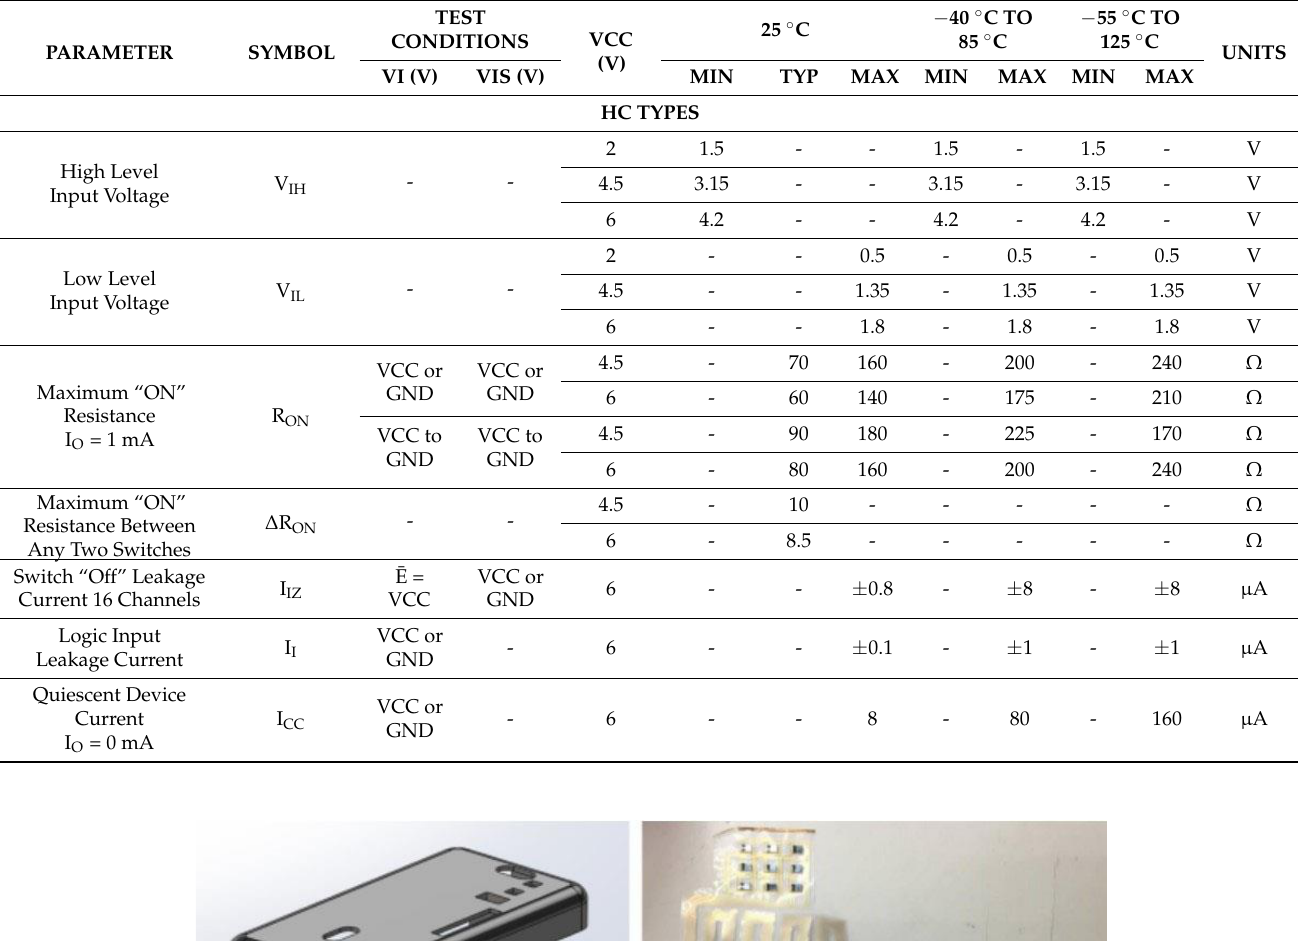
Table 4. Datasheet of the high-speed CMOS 16-channel analog multiplexer/demultiplexer CD74HC4067.